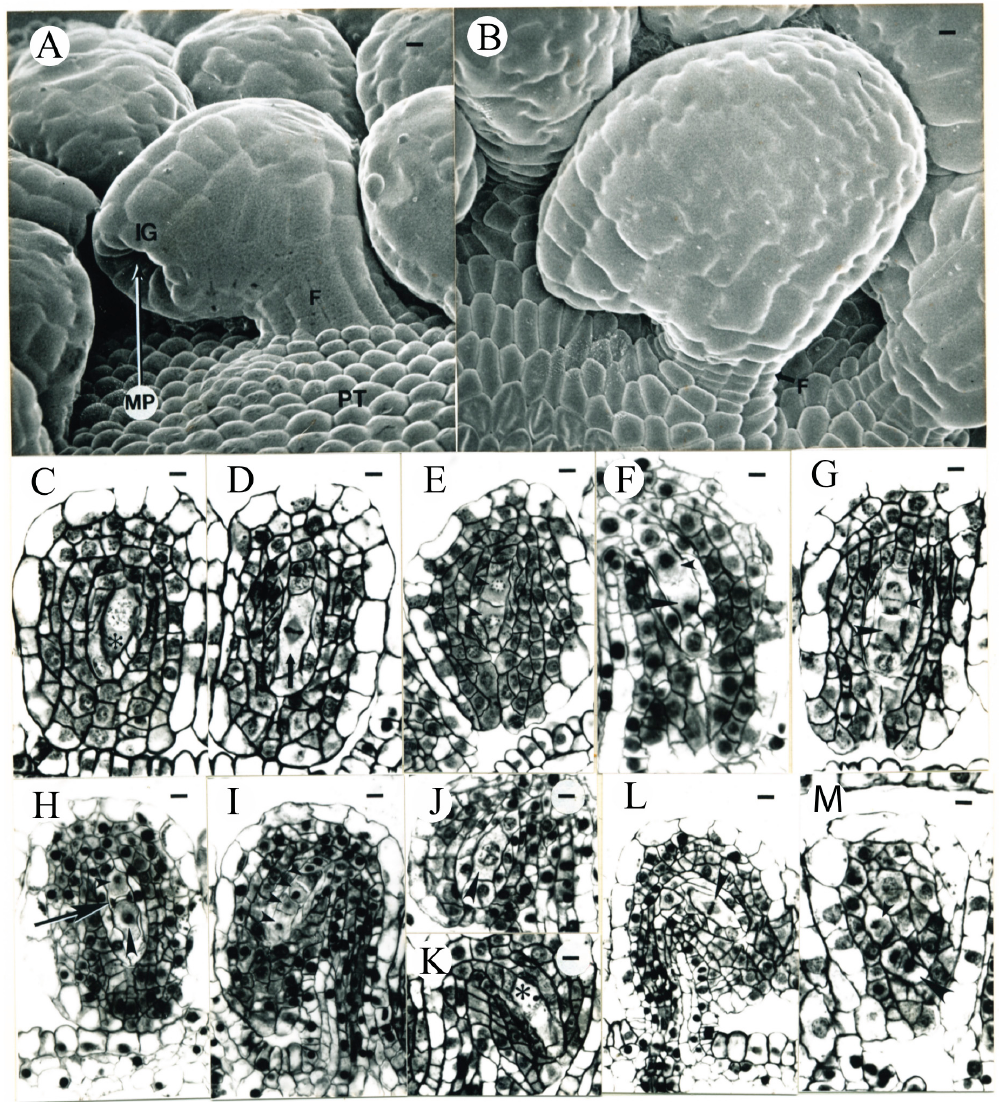
Figure 10. Tobacco ovule development 16.2 ± 0.4 days after ECP. ( A ) SEM micrograph of the anatropous ovules from the peripheral region of the placenta. F, funiculus; IG, integument; MP, micropyle; PT, placental epidermis. Bar = 7.0 µ m. ( B ) SEM micrograph of the anatropous ovules from the middle portion of the placenta. F, funiculus. Bar = 7.0 µ m. ( C – I ) Transverse sections of ovules similar to the one seen in the middle of ( B ). ( C ) Megasporocyte (asterisk) in prophase I. Bar = 8.1 µ m. ( D ) Megasporocyte (arrow) in metaphase I. Bar = 8.1 µ m. ( E ) Two dyad cells in prophase of meiosis II (arrowheads). Bar = 10 µ m. ( F ) Two dyad cells asynchronous in meiosis II. The micropylar dyad cell is indicated by a larger arrowhead, while the chalazal dyad cell is indicated by a smaller arrowhead. Bar = 7 µ m. ( G ) Two dyad cells asynchronous in meiosis II. The micropylar dyad cell is in metaphase II (larger arrowhead), while the chalazal dyad cell is indicated by a smaller arrowhead. Bar = 8.1 µ m. ( H ) Micropylar dyad cell in metaphase II (larger arrowhead). One of the two chalazal megaspores has degraded (arrow) and is flanked by the micropylar dyad cell and the other chalazal megaspore (smaller arrowhead). Bar = 10 µ m. ( I ) Linear tetrad of 4 megaspores (arrowheads) in the ovule. Bar = 10 µ m. ( J – M ) Transverse sections of ovules similar to the one seen in the middle of ( A ). ( J , K ) Megasporocytes in prophase I (arrowhead, asterisk). Bar = 9 µ m. ( L ) Megasporocyte in metaphase I (arrowhead). Bar = 11.5 µ m. ( M ) Two dyad cells (arrowheads). The micropylar dyad cell is identified by the larger arrowhead. Bar = 7.5 µ